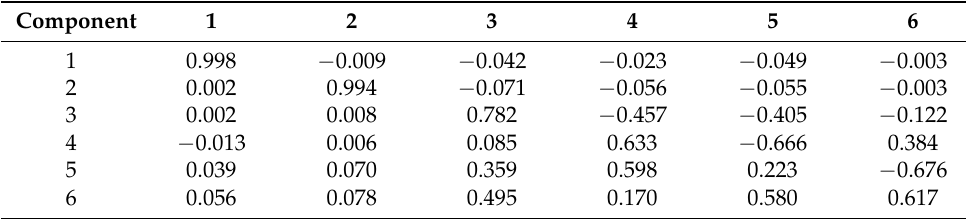
Figure 7. Scree plot showing characteristics of each component. Table 8. Component transformation matrix.